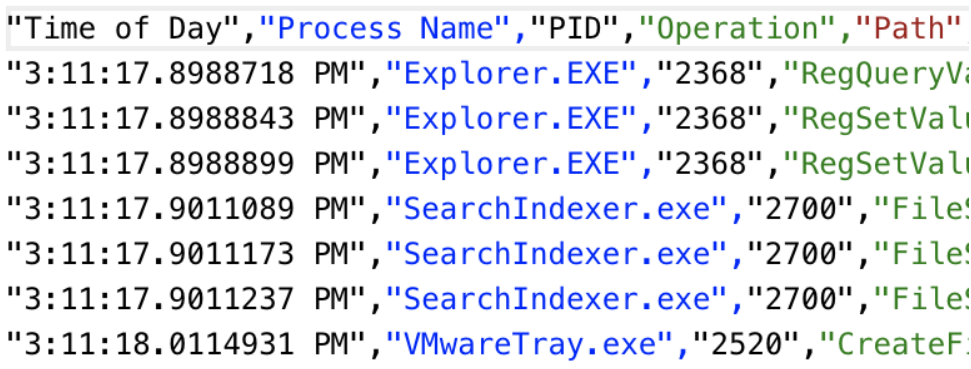
Figure 4. Log of malware behavior.